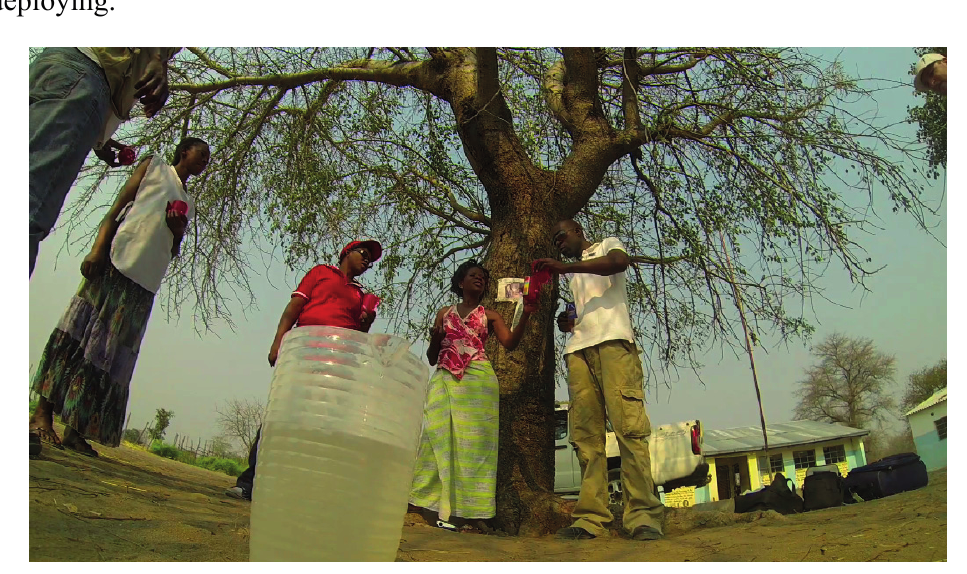
Figure 4. Zambian subsistence farmers play the UpRiver game in the village of Kazungula to learn about the predictability of changing water levels on the Zambezi river. The game helps players understand the value of self-organization for flood warnings and disaster